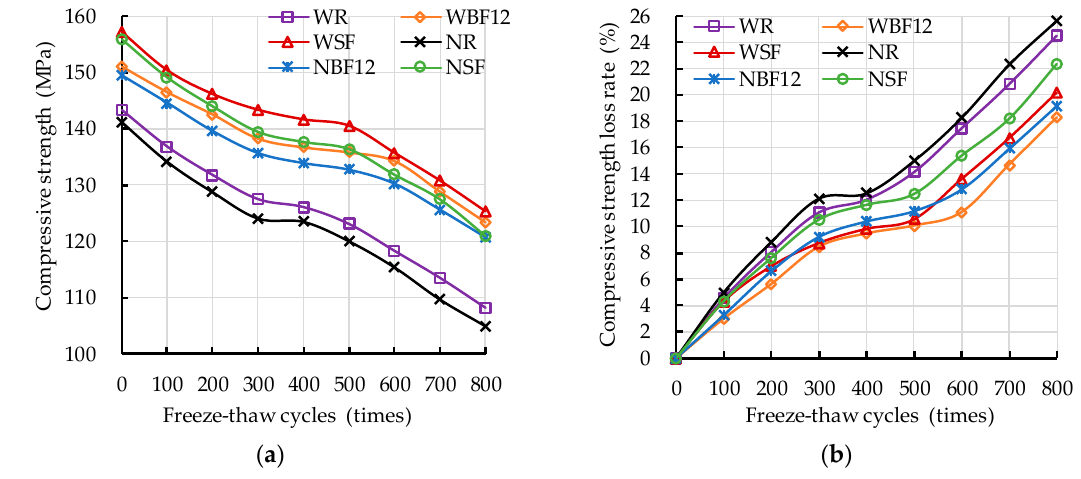
Figure 9. Compressive strength and Compressive strength loss rate versus freeze – thaw cycles: ( a ) Compressive strength; ( b ) Compressive strength loss rate.